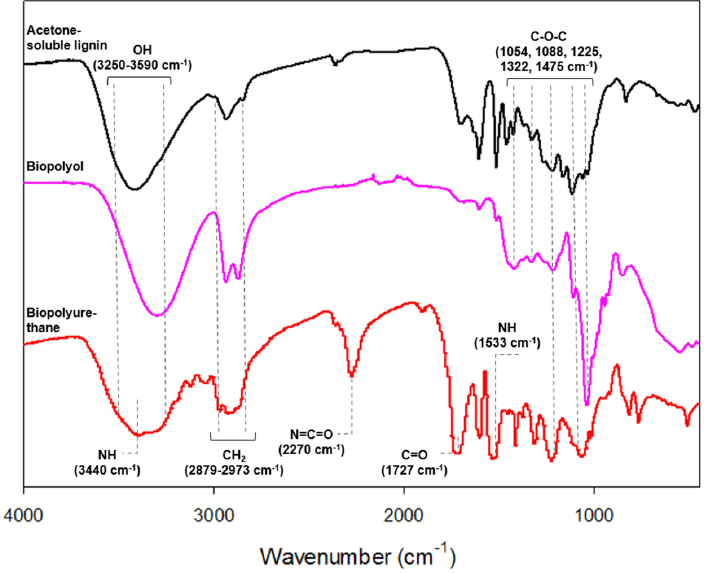
Figure 6. FT-IR spectra of acetone-soluble lignin, optimal biopolyol, and biopolyurethane foam.